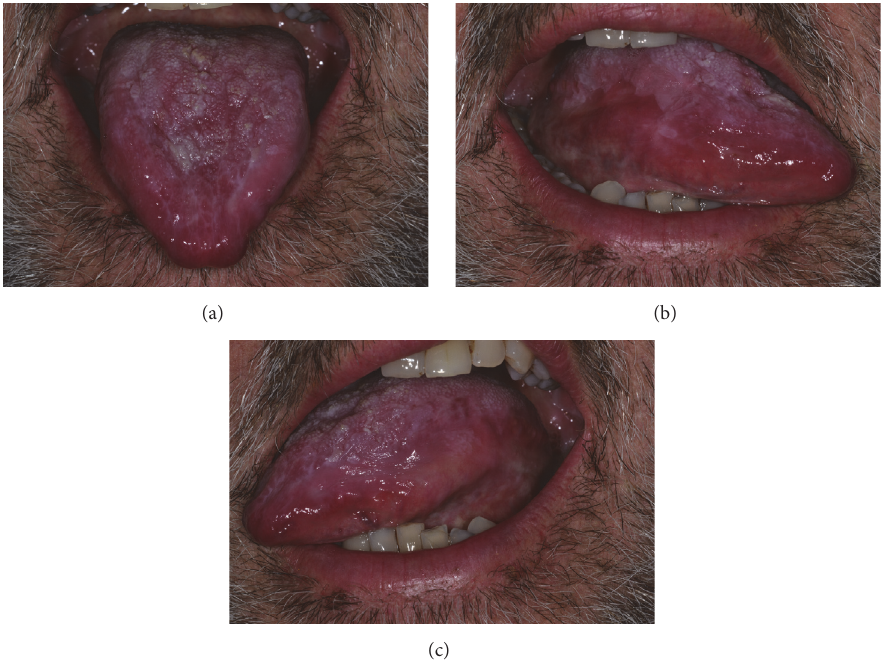
Figure 2: (a–c) Complete disappearance of the erosive tongue lesion at the end of the treatment